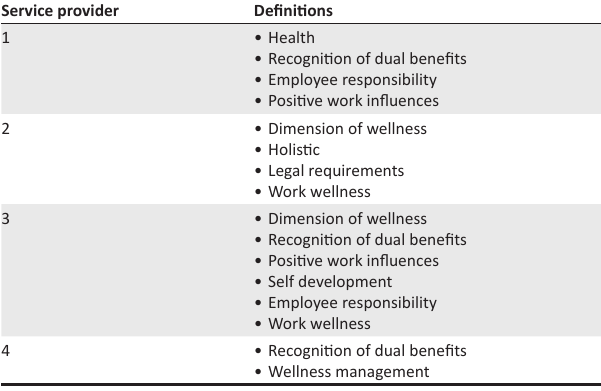
Table 4 gives the reasons for introducing Employee Wellness Programmes according to the participating organisations, service providers and labour unions.